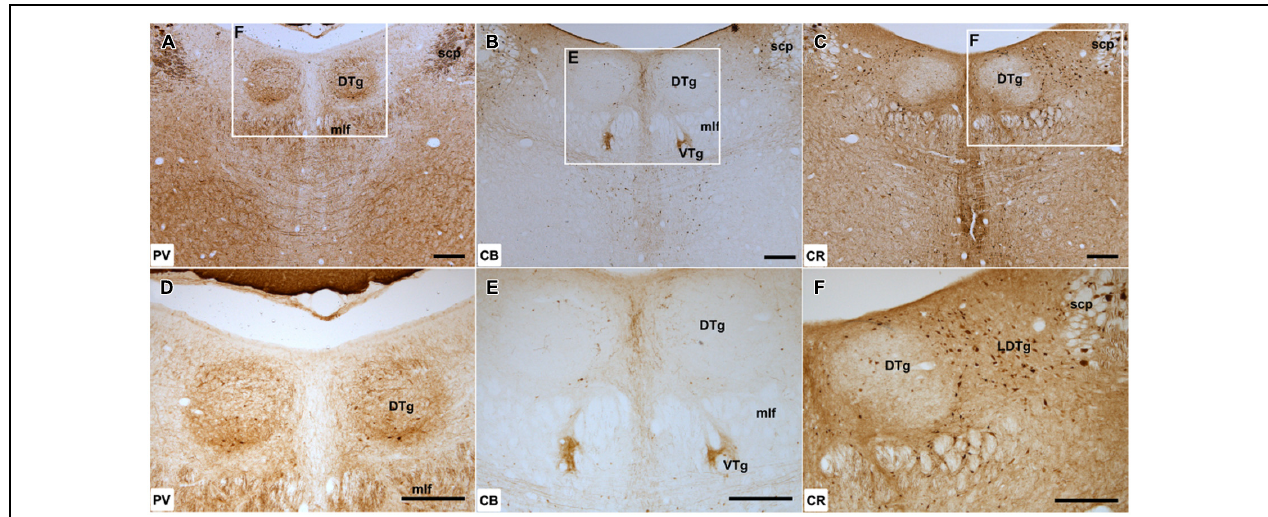
FIGURE 1 | Dorsal tegmental nucleus of Gudden: (A–C), Low magnification (50 × magnification) photomicrograph of parvalbumin (PV; A), calbindin (CB; B), and calretinin (CR; C) immunoreactivity in coronal sections of the rat midbrain. PV label was present throughout DTg, but the densest cellular and neuropillar label was confined to the pars ventralis division of the nucleus. CB immunoreactivity was virtually absent within the dorsal